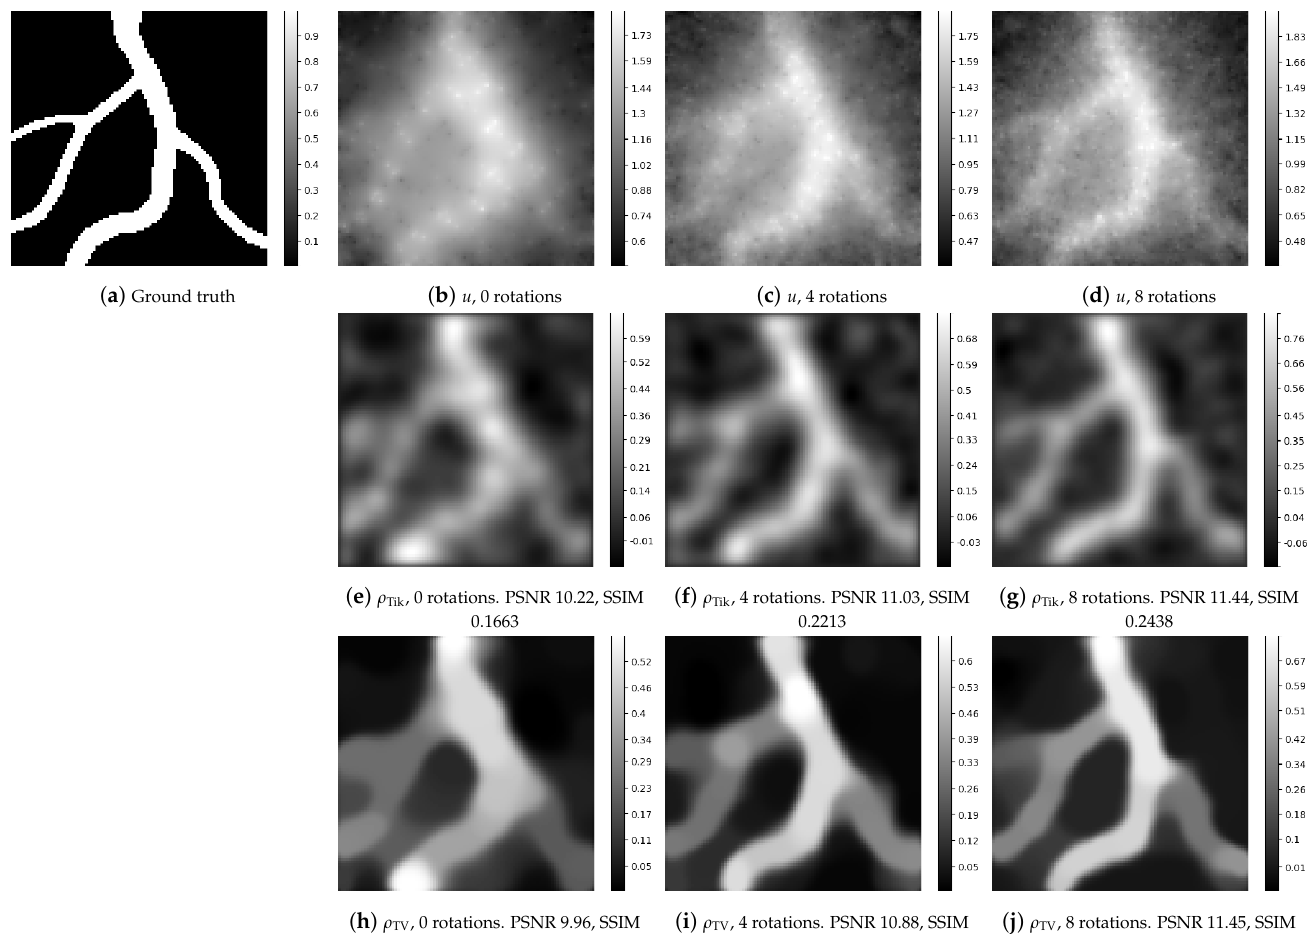
Figure 7. Reconstruction of a vessel-shaped phantom with finer structures using model-based two- stage reconstruction for combining rotated scan trajectories. First row. Trace fields u = trace A [ ρ ] (output of Stage 1) obtained with increasing number of rotations 0,4,8. Second row. Reconstruction results ρ Tik using Tikhonov regularized deconvolution in Stage 2 with increasing number of rotations. Third row. Reconstruction results ρ TV using TV smooth regularized deconvolution in Stage 2 with increasing number of rotations. We observe qualitatively that again merging rotated scans helps to enhance the quality of the reconstruction for both Tikhonov and TV type regularization. In particular, the locations of junctions become more distinctive with rotations. We observe here too, that finer structures of smaller scale are generally more difficult to reconstruct but still become better perceptible when rotated scans are